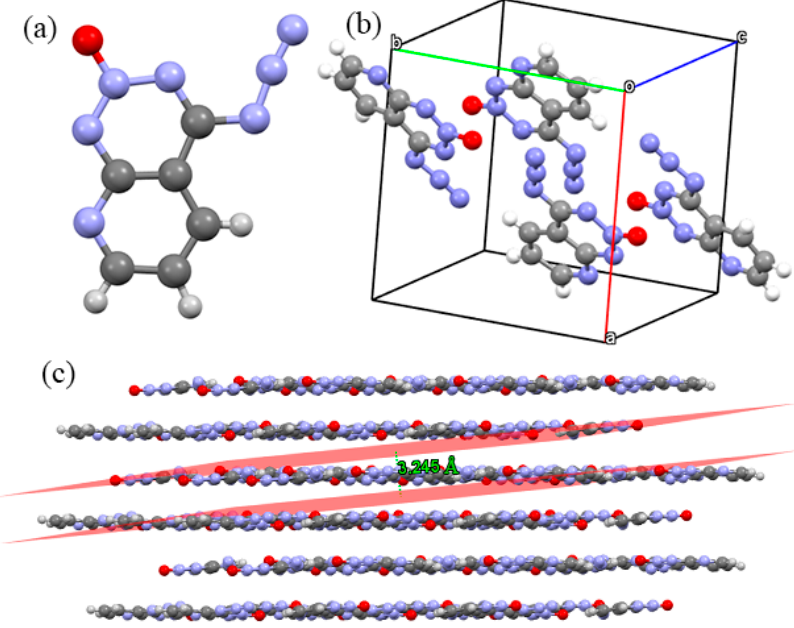
Figure 3. Crystal structures and geometrical configuration of Crystal b : ( a ) crystal structure; ( b ) single unit cell; ( c ) the 3D extended structure.